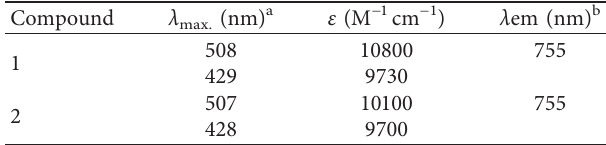
Figure 2: Cyclic voltammograms for complexes 1 (black trace) and 2 (red trace) in acetonitrile. Table 3: E 1/2 values for complexes 1 and